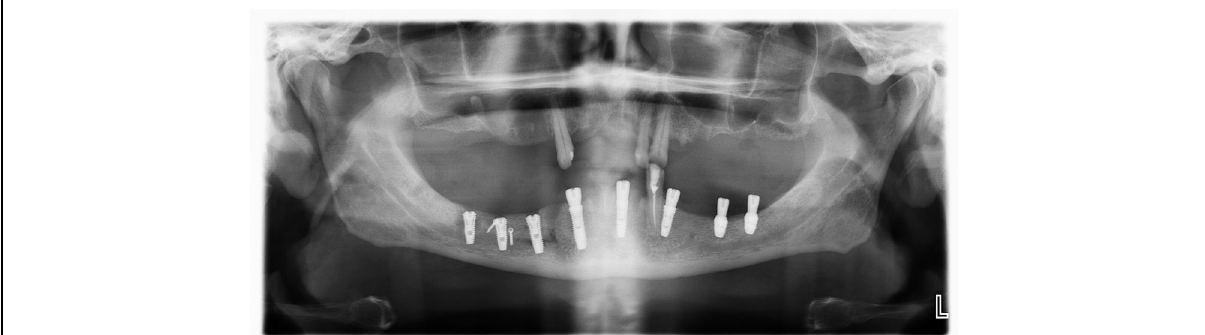
Fig. 6 A panoramic radiography after IAN transposition and implant placement